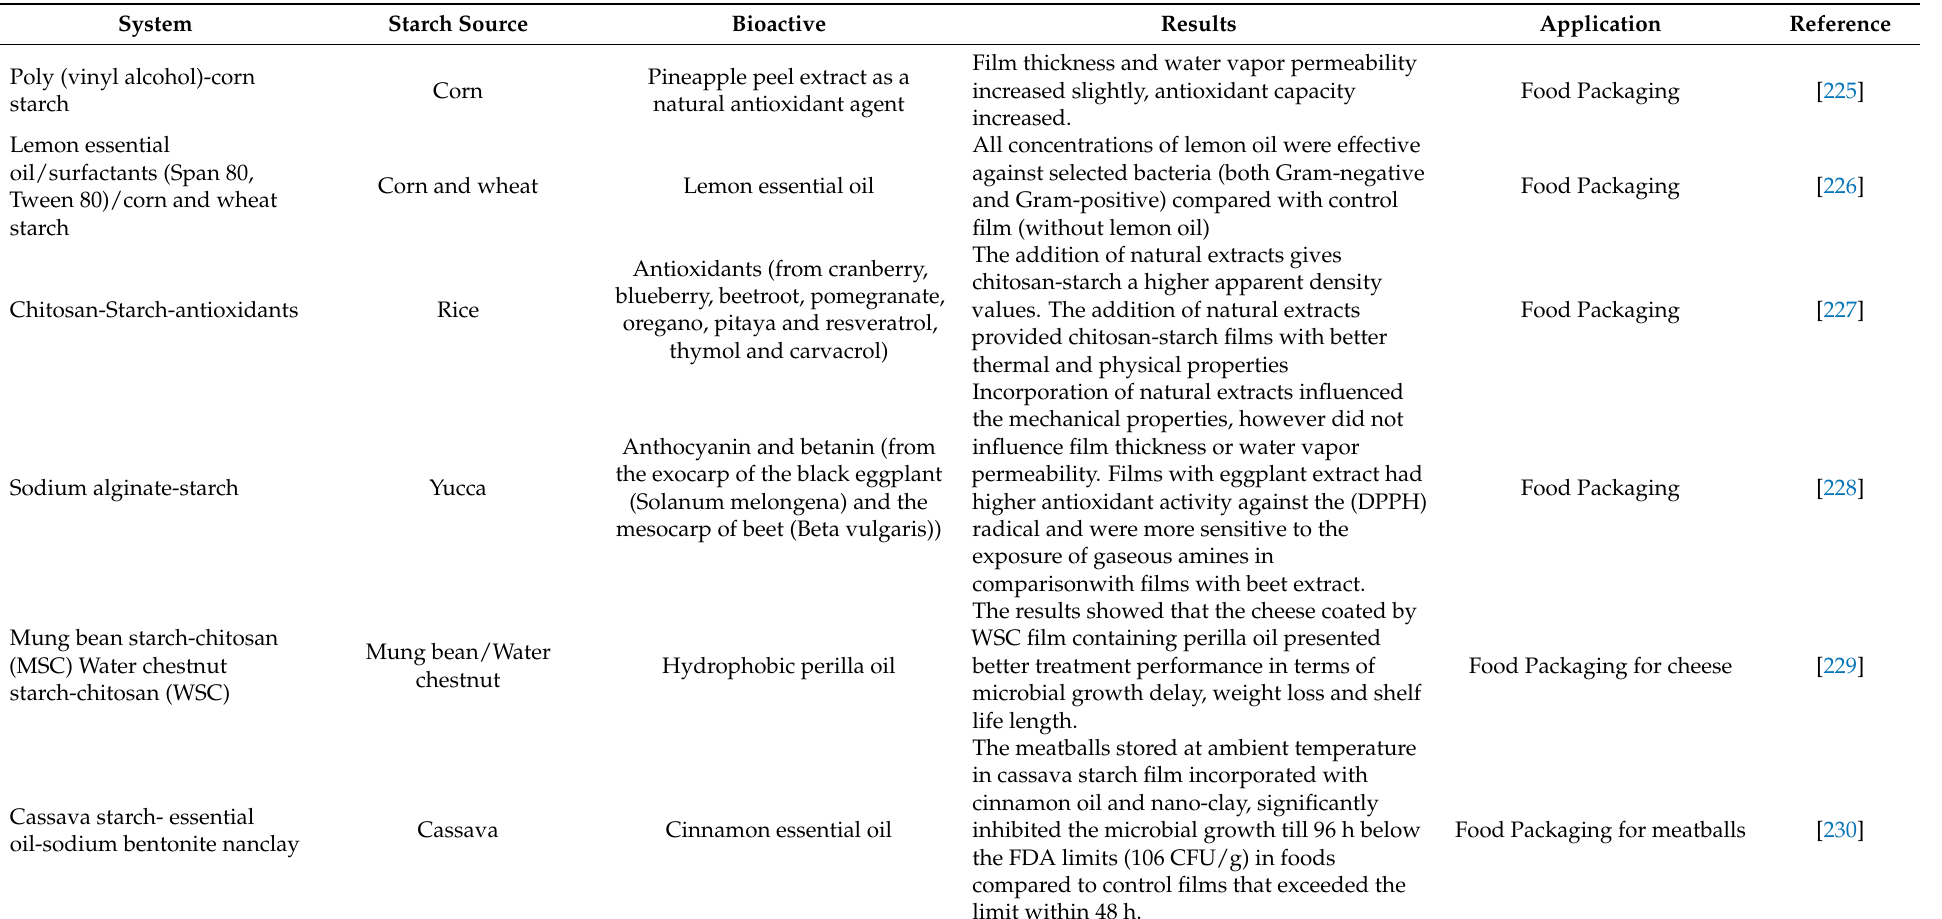
Table 6. Bioactive system, processing techniques and main results of bioactive starch based materials for food